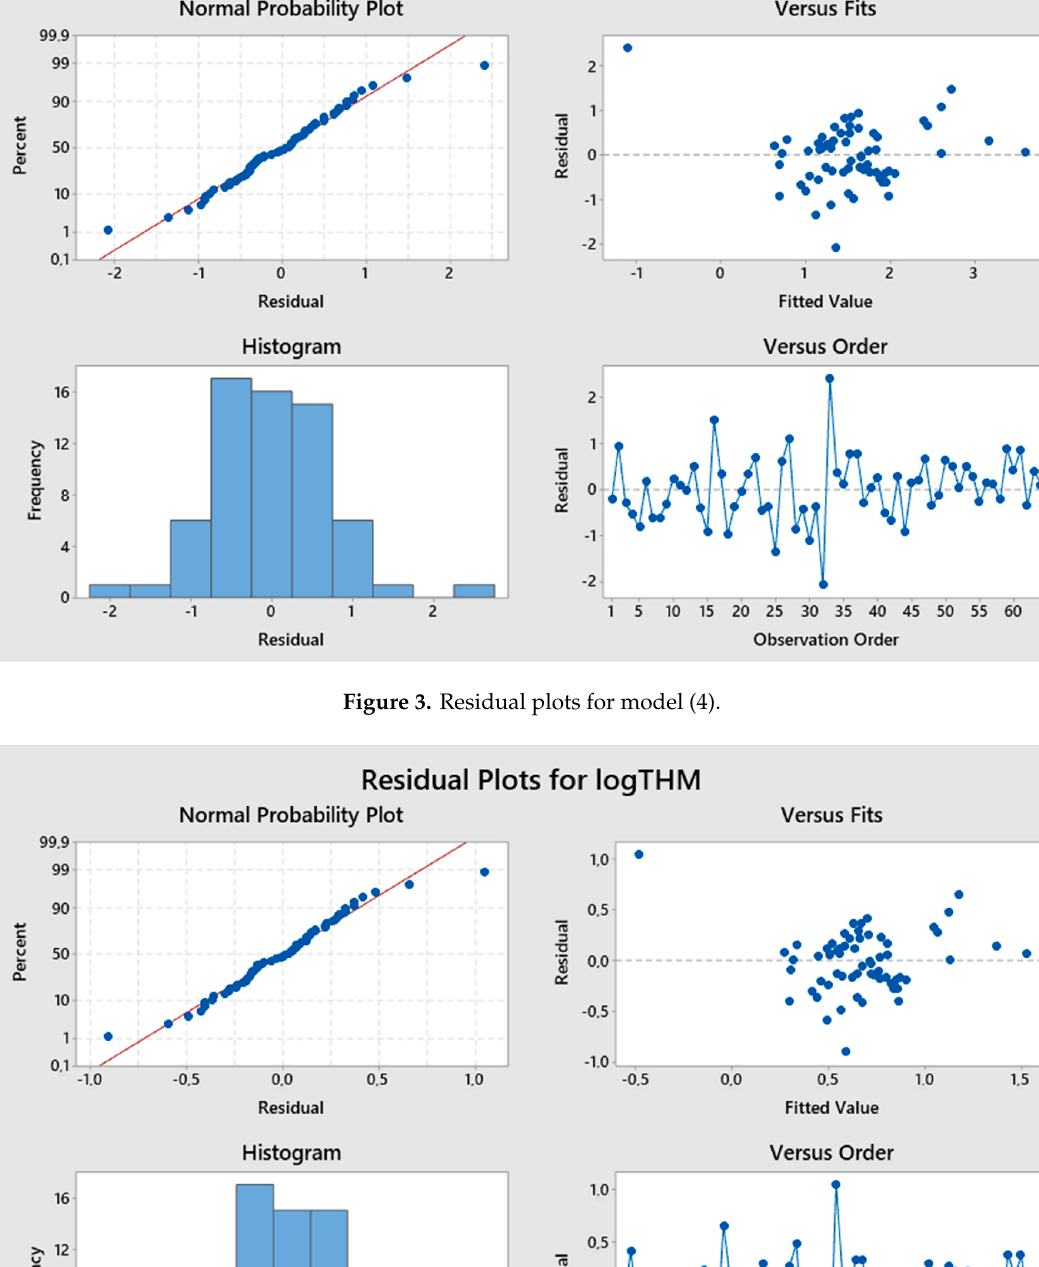
Figure 2. Residual plots for model (3).